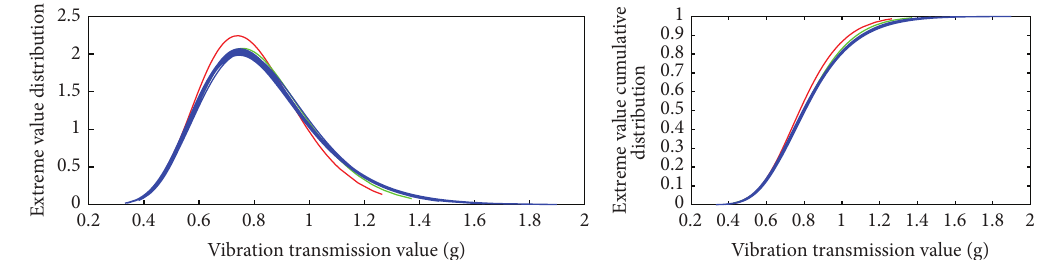
Figure 2: Maximum distribution curves with increasing data amount.